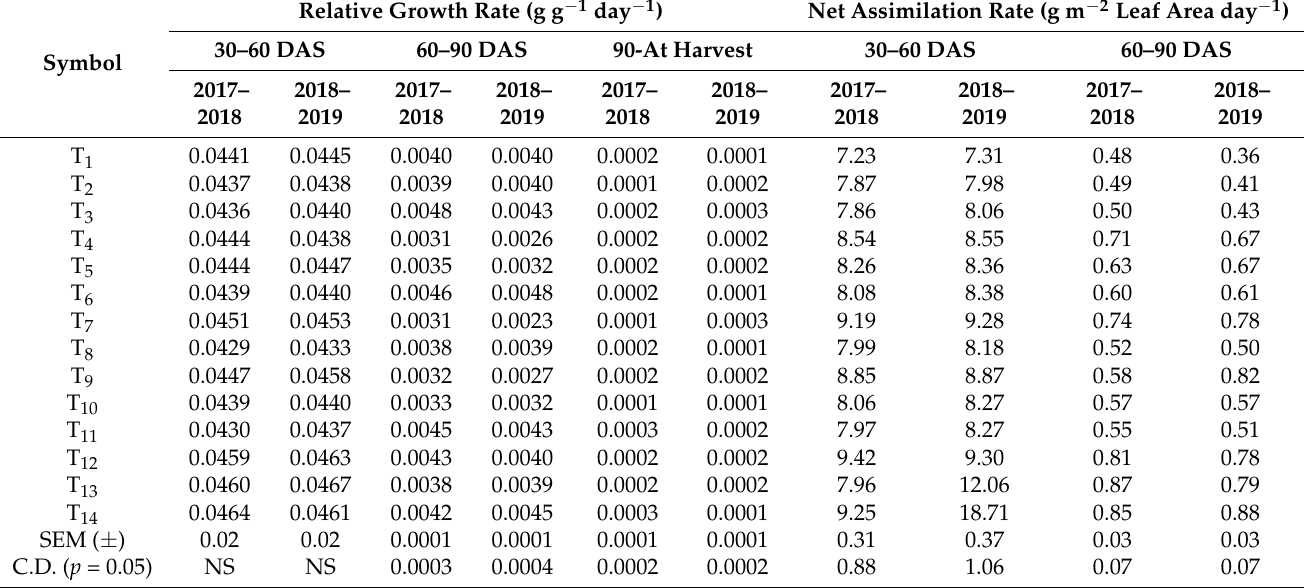
Table 3. Nutrient management strategies effects on relative growth rate (g g − 1 day − 1 ) and